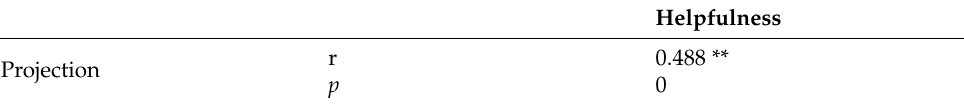
Table 4. Results of remarkable otherness